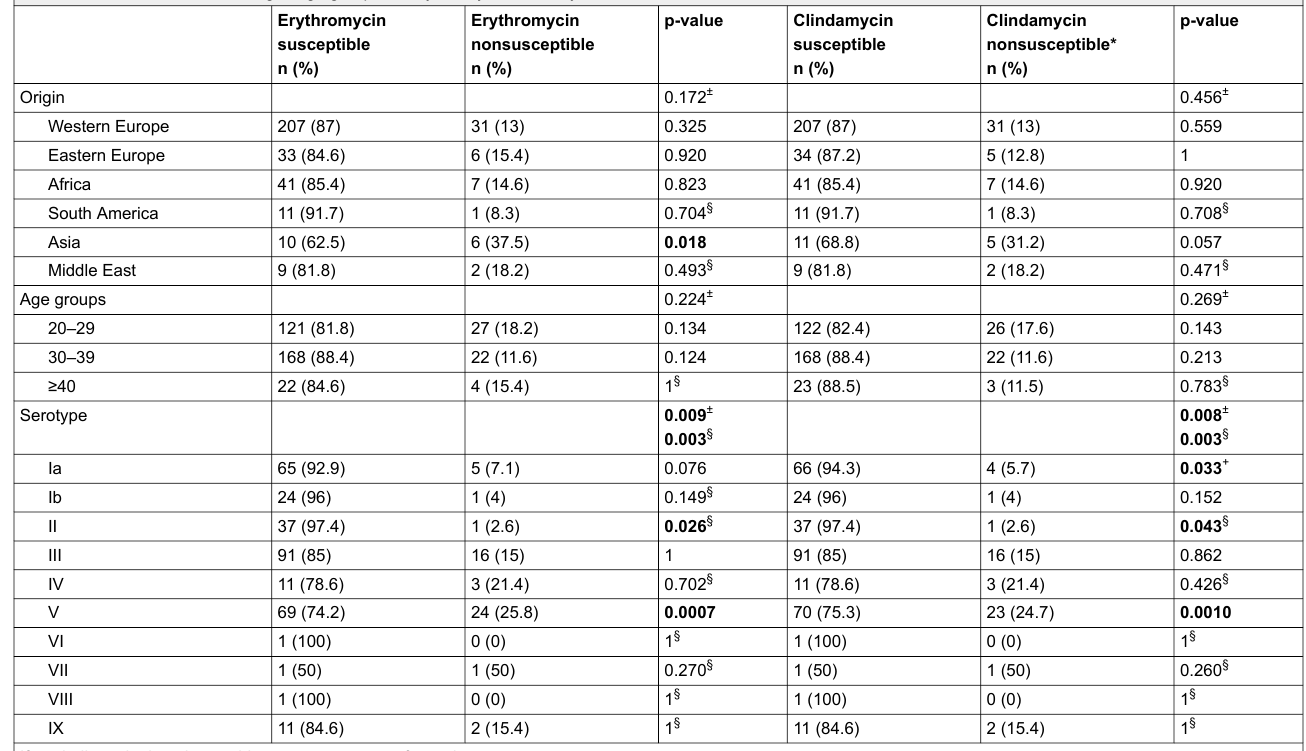
Table 2: Association between origin, age group and erythromycin/clindamycin resistance. Erythromycin